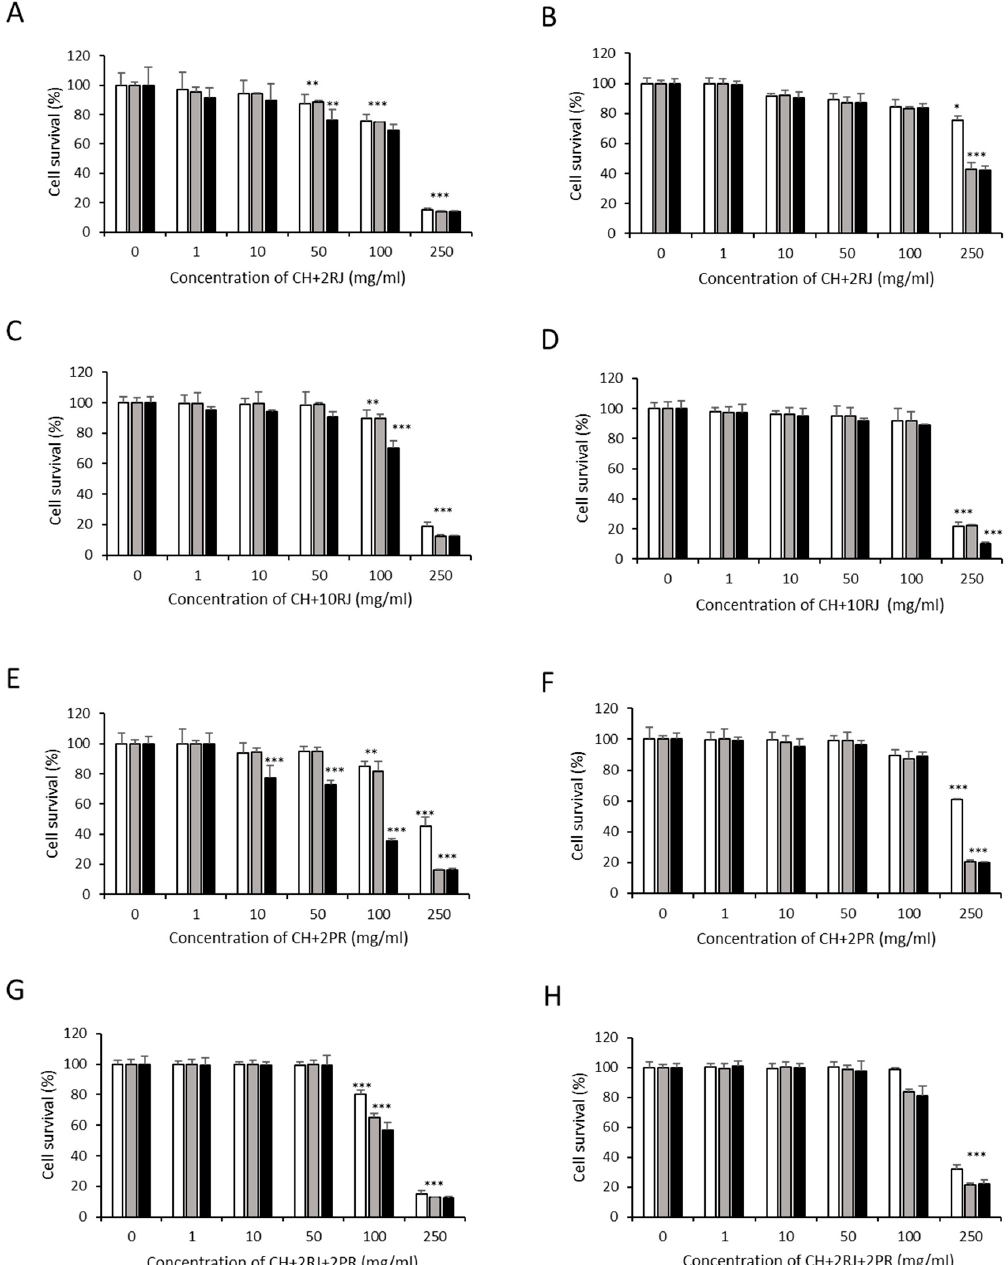
Figure 3. Effects on the viability of HepG2 ( A , C , E , G ) and WRL-68 ( B , D , F , H ) cells of sample 7 (CH+2RJ) ( A , B ), sample 8 (CH+10RJ) ( C , D ), sample 9 (CH+2PR) ( E , F ), and sample 13 (CH+2RJ+2PR) ( G , H ) by MTT assay. Cells were cultured with different doses of samples (0–250 mg/mL) for 24 ( □ ), 48 ( ■ ), and 72 h ( ■ ). Asterisks indicate a significant difference from the control (0). * p ≤ 0.05, ** p ≤ 0.01, *** p ≤ 0.001.